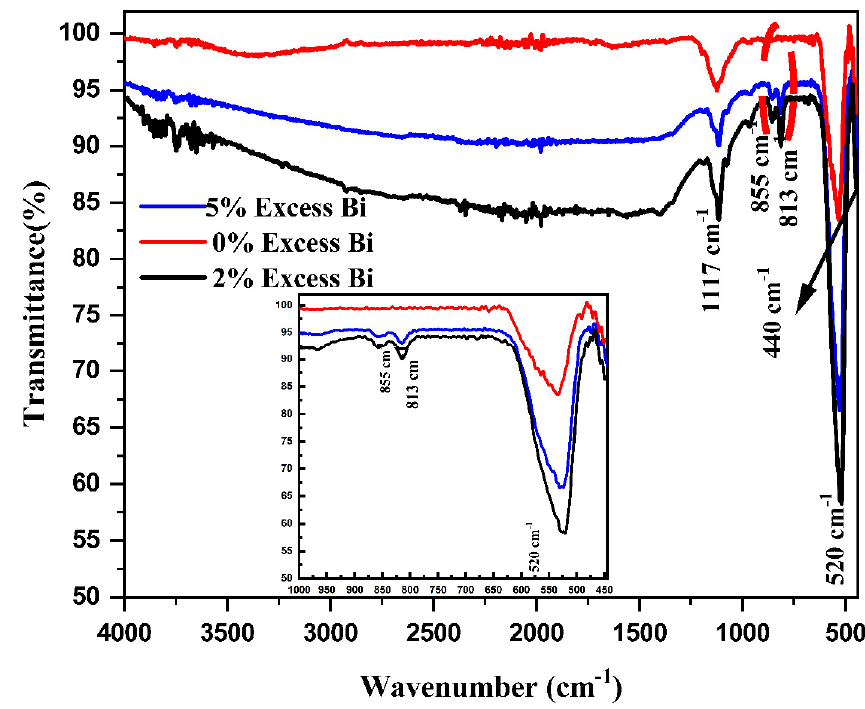
Figure 2. FT-IR spectrum of BFO (0%, 2% and 5% Excess Bi) nanoparticles.